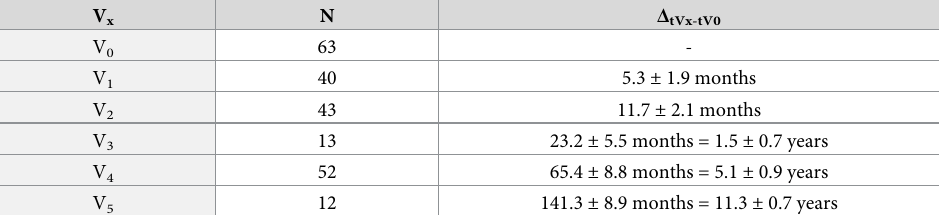
Table 1. Time table of follow-up visits of AE patients. Vx = follow-up visit, N = number of cases that adhered to fol- low-up visit, Δ tVx-tV0 = difference between baseline and follow-up